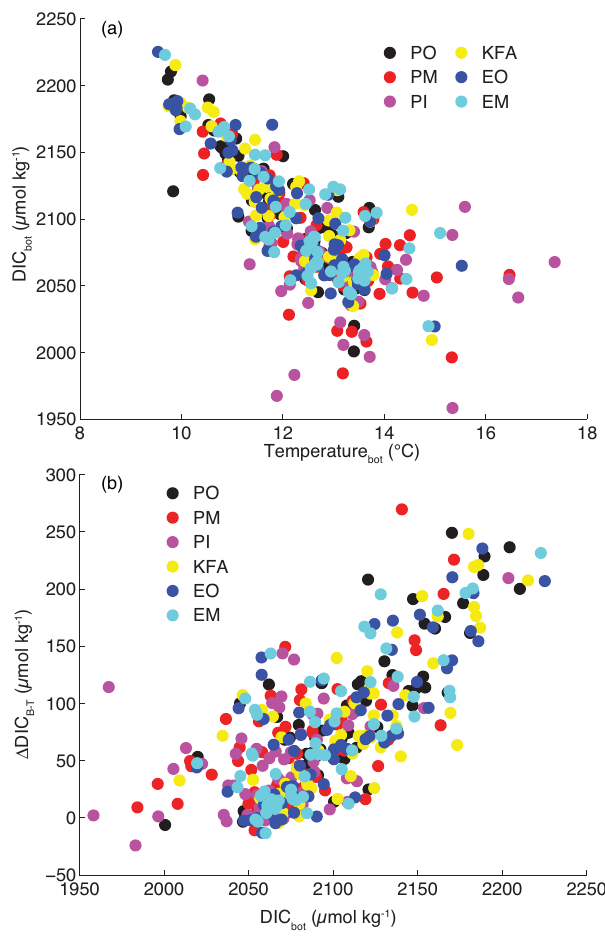
Figure 8. (a) Bottom DIC-bottom temperature relationships for all six sites and (b) bottom-to-surface DIC gradients as a function of bottom DIC concentrations.